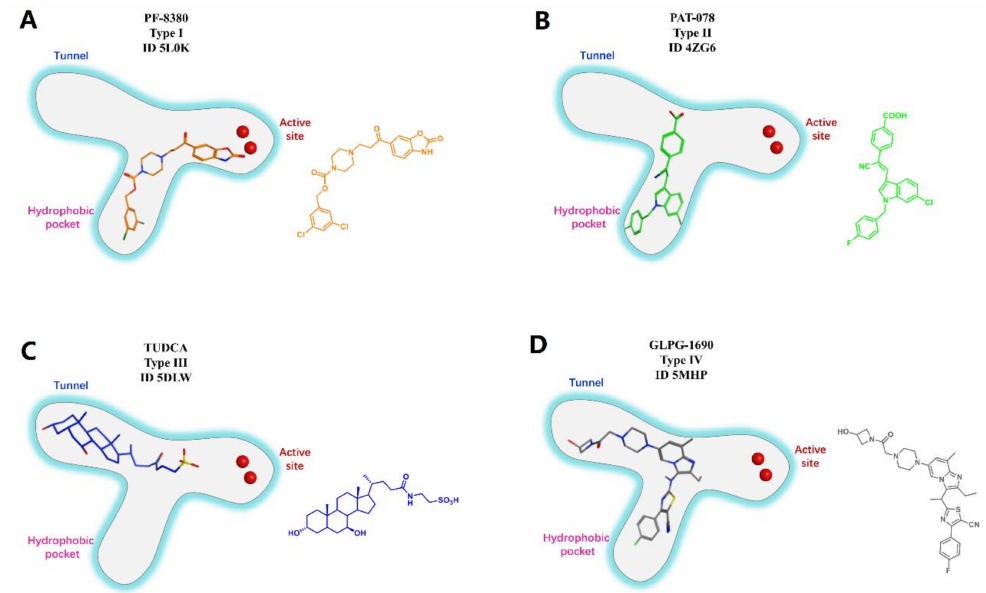
Figure 2. Classification of the reported representative ATX inhibitor types based on binding modes. Left: Schematic diagrams of the binding modes with 3D structures of ATX inhibitor; Right: 2D struc- tures of ATX inhibitor. ( A ). PF-8380, type I, (ID 5L0K); ( B ). PAT-078, type II, (ID 4ZG6); ( C ). TUDCA, type III (ID 5DLW); ( D ). GLPG-1690, type IV, (ID